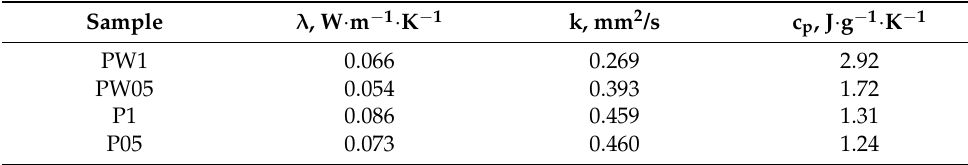
Table 4. Thermal properties of